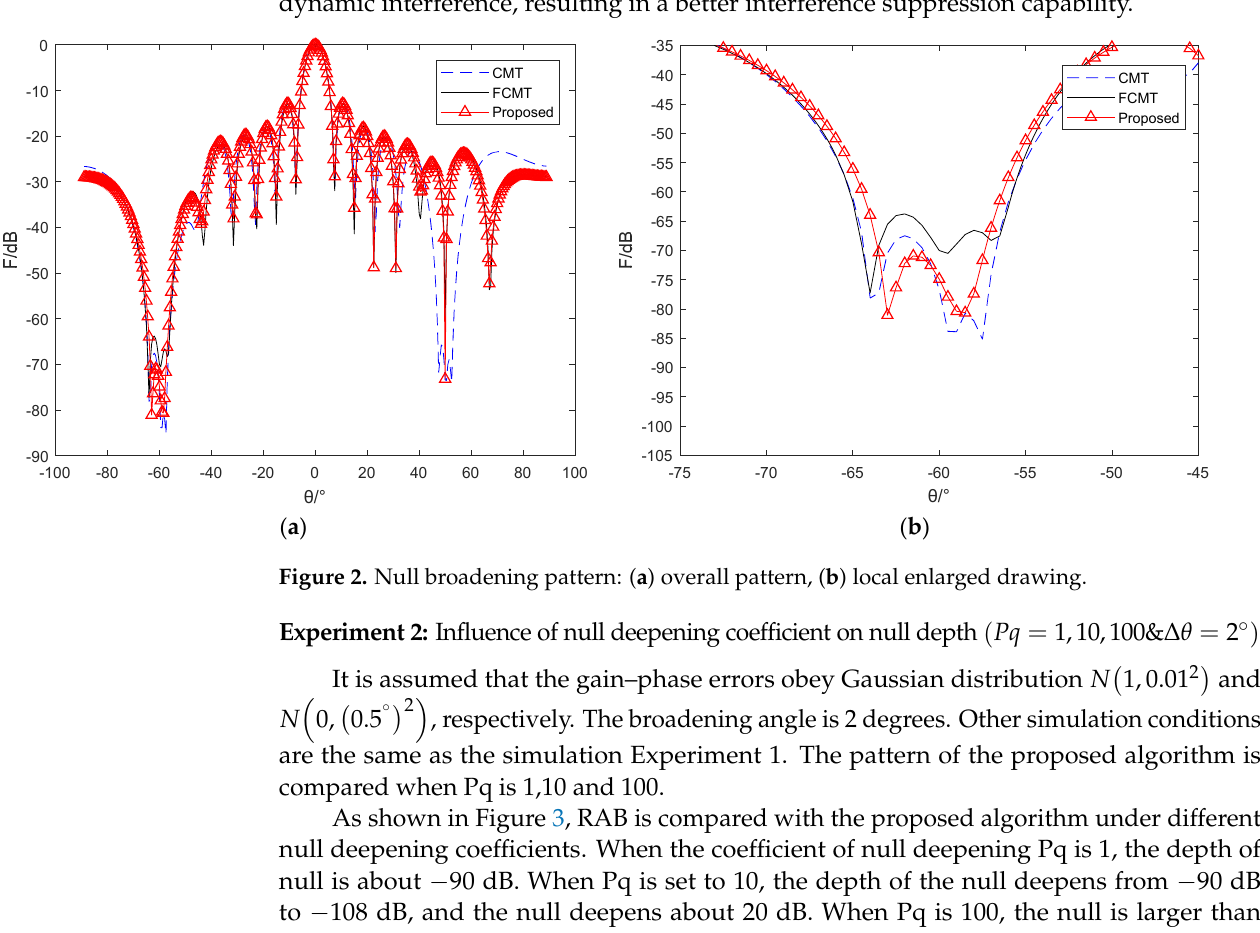
Figure 2. Null broadening pattern: ( a ) overall pattern, ( b ) local enlarged drawing. Experiment 2: Influence of null deepening coefficient on null depth ( Pq = 1,10,100& ∆ θ = 2 ◦ ) .